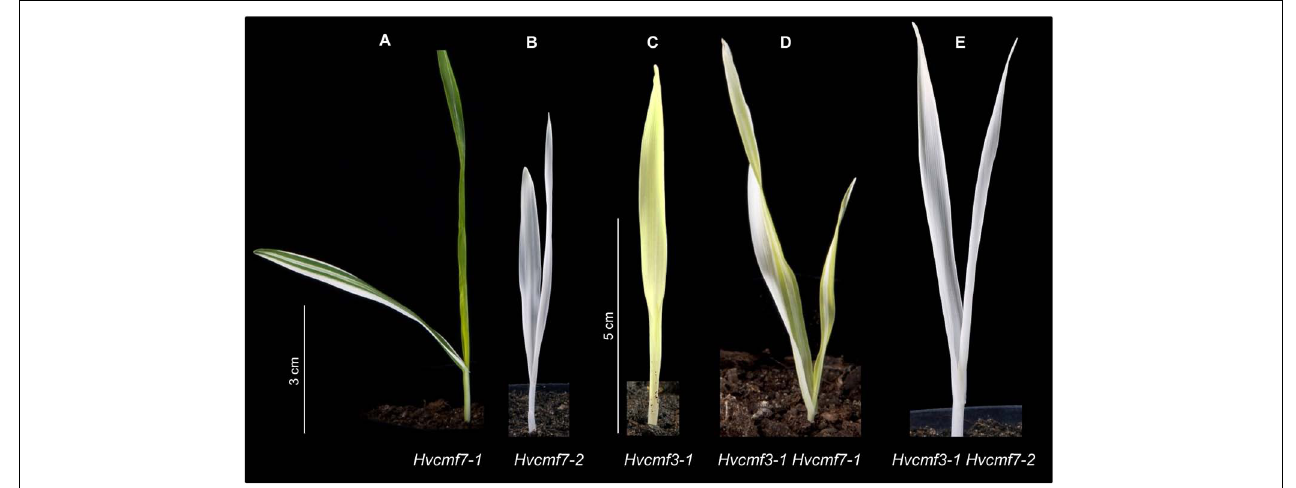
FIGURE 10 | Phenotype of double mutant Hvcmf3/Hvcmf7 . (A) The original albostrians mutant Hvcmf7-1 shows a green-white striped phenotype. (B) The albostrians pre-stop TILLING mutant Hvcmf7-2 exhibits a complete albino phenotype. (C) Phenotype of Hvcmf3-1 mutant at 7 days after germination. (D) Double mutant Hvcmf3-1 Hvcmf7-1 shows a xantha -albino striped phenotype. (E) Double mutant Hvcmf3-1 Hvcmf7-2 exhibits albino phenotype. Scale bars: (A,B) 3 cm; (C–E) 5